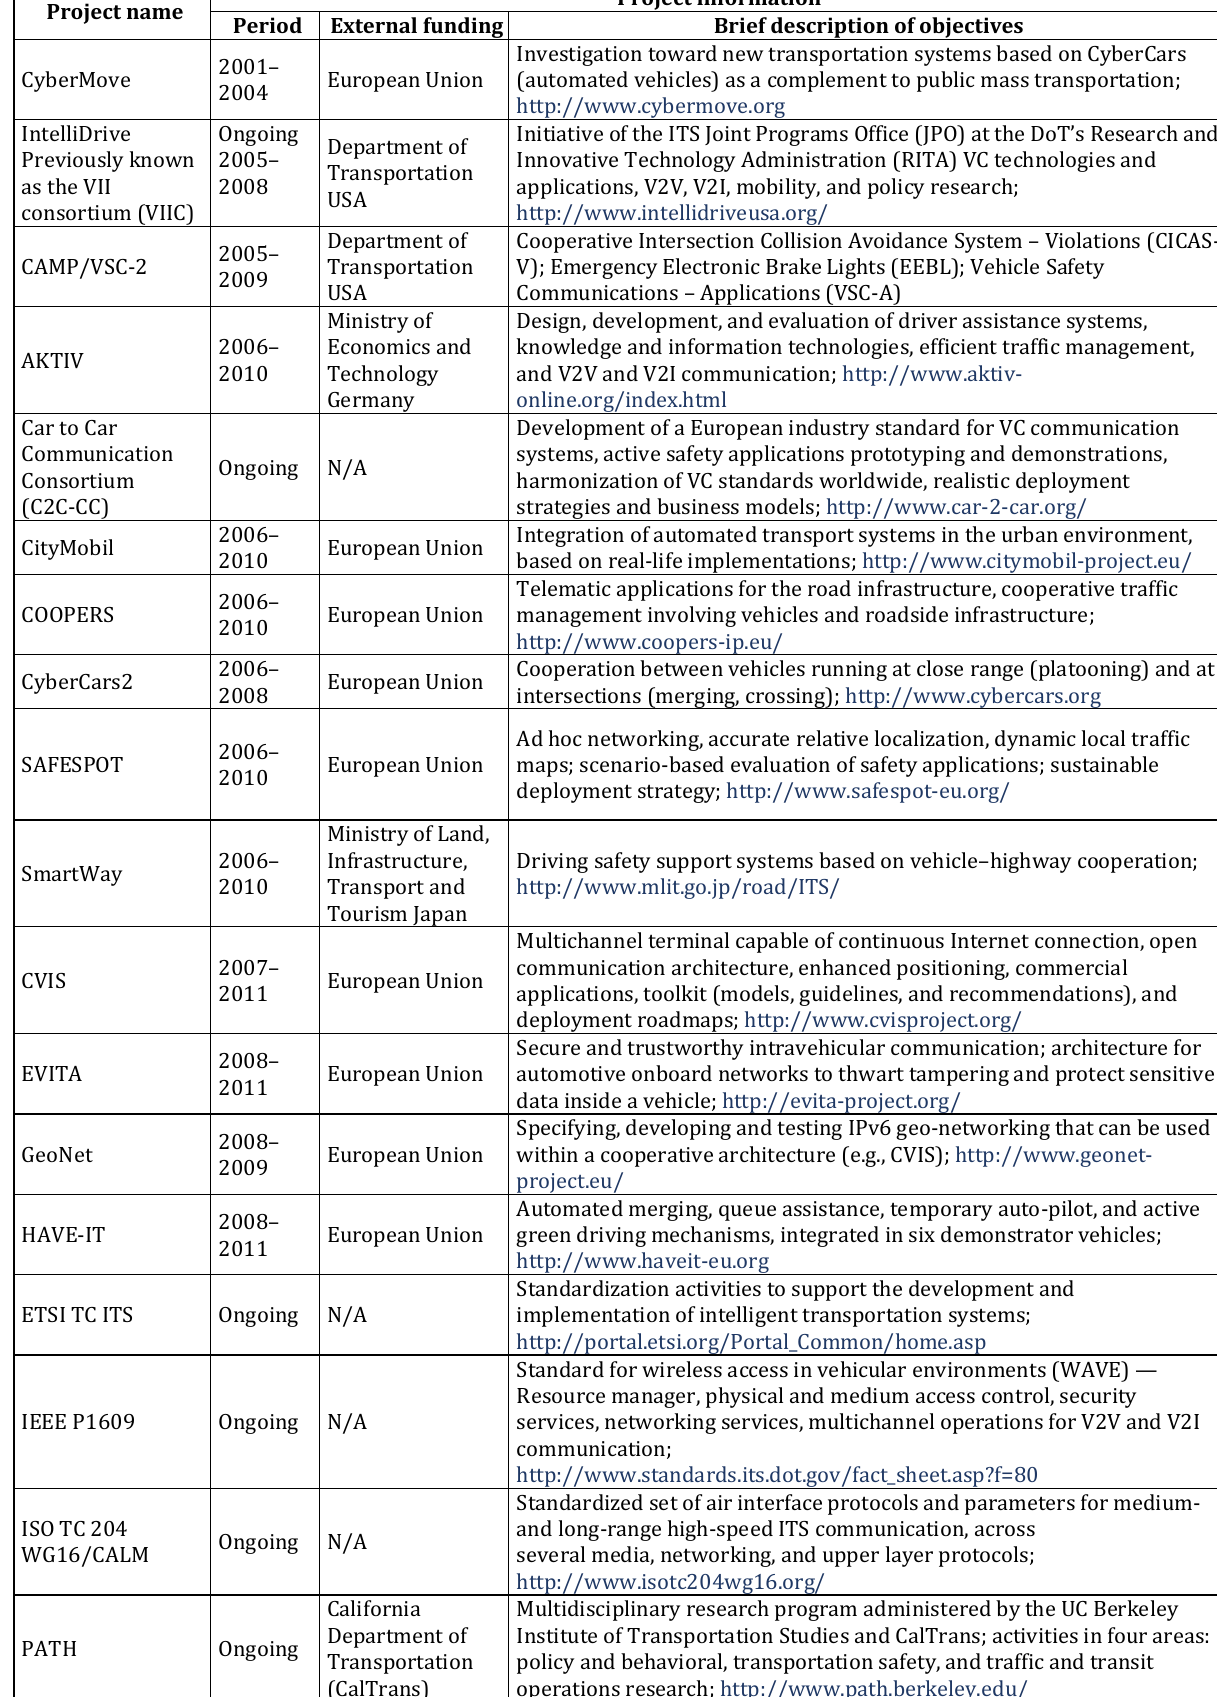
Table 1. Summary information on representative VC projects, consortia, and working